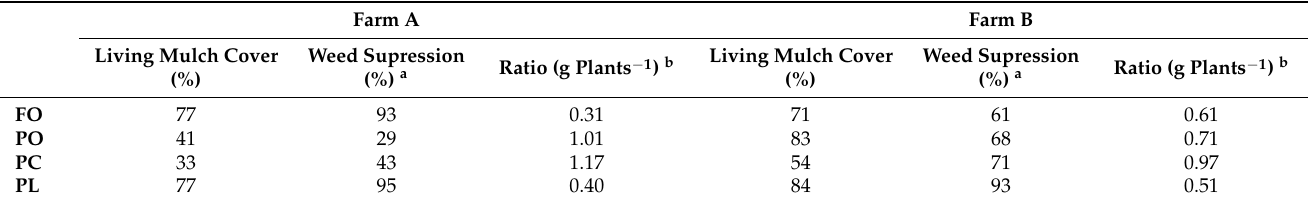
Table 6. Summary table showing for each living mulch (FO, Festuca ovina ; PO, Pilosella officinarum ; PC, Plantago coronopus , and PL, Plantago lanceolata ) the average living mulch cover, weed suppression percentage and weed biomass/weed density ratio.